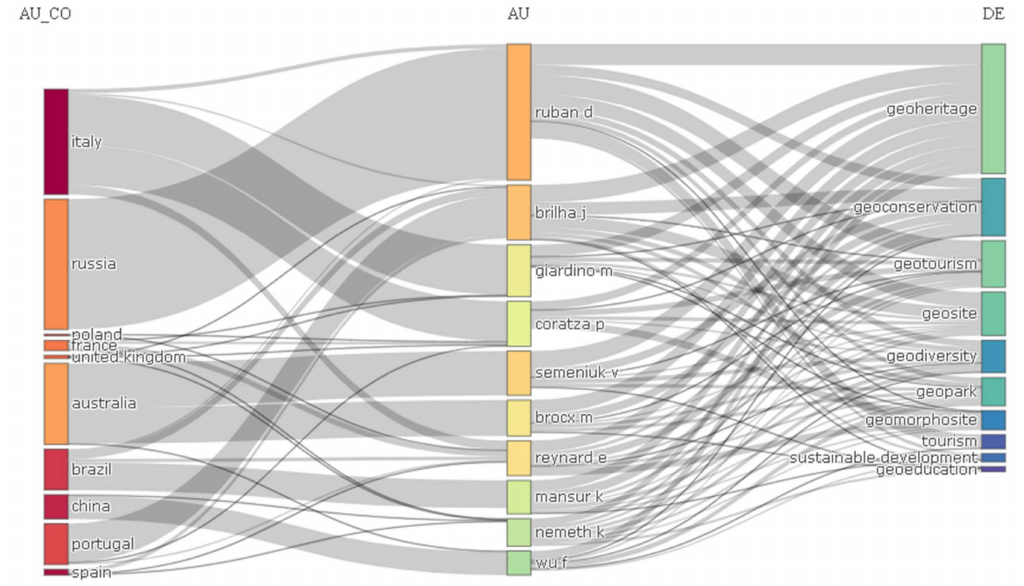
Figure 5. Sankey diagram showing the list of countries (AU_CO), authors (AU), and research topics (DE) from global data